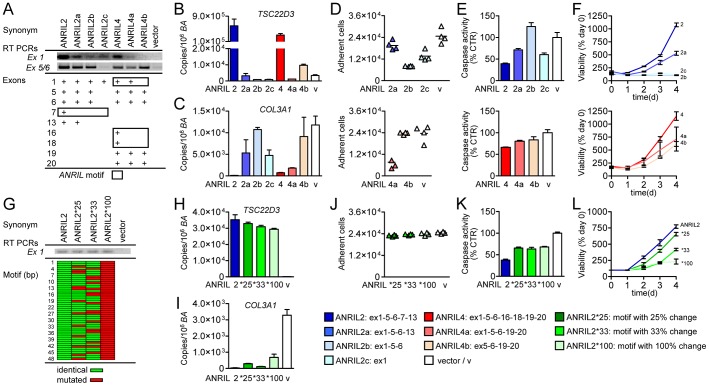
Pivotal role for Alu motif in ANRIL RNA function.(A) Cell lines over-expressing variants of ANRIL2 (ANRIL2a, 2b, 2c) and ANRIL4 (ANRIL4a, 4b) devoid of Alu motif sequences highlighted by boxes. Validation of over-expression using qRT-PCR assays. (B) Reversal of up-regulation (TSC22D3) and (C) down-regulation (COL3A1) of ANRIL target-gene mRNA expression in ANRIL2a-2c and ANRIL4a,4b compared to ANRIL2 and ANRIL4. Reversal of (D) cell adhesion, (E) apoptosis, and (F) proliferation in cell lines over-expressing mutant ANRIL isoforms. (G) Stable cell lines containing mutated forms of the Alu motif in ANRIL2. Positions of nucleotide exchanges (0, 25%, 33%, and 100%) in the 48 base-pair Alu motif are indicated in red. (H,I) Reversal of trans-regulation in mutant cell lines compared to ANRIL2. (J) Cell adhesion, (K) apoptosis, and (L) proliferation in mutant cell lines. (B,C,H,I,F,L) 3–4 biological replicates/isoform.(D,E,J,K) quadruplicate measurements per pool of 2–3 biological replicates. Error bars indicate s.e.m.